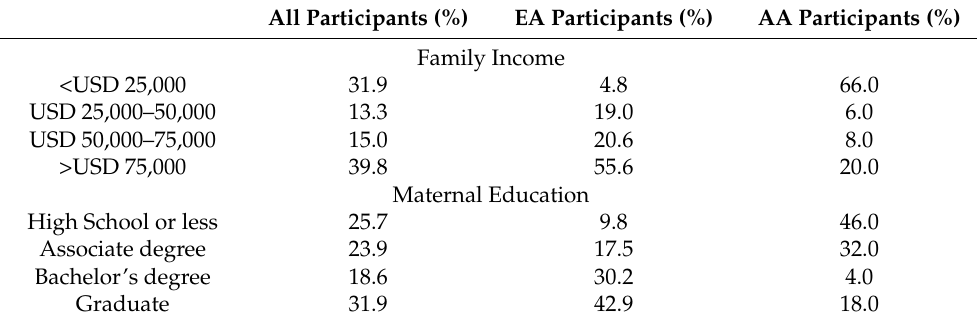
Table 3. General characteristics for family income and maternal education of the